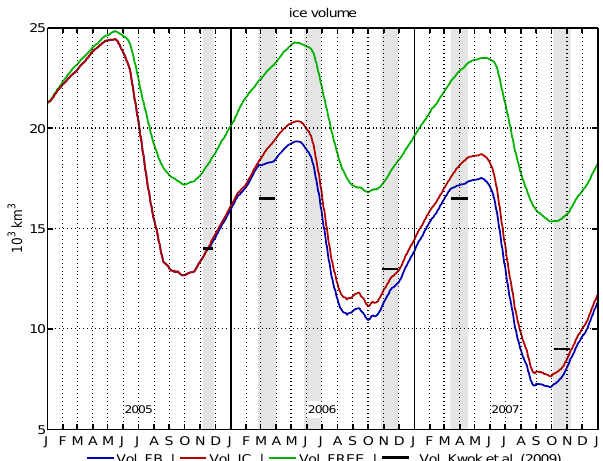
Fig. 5. Time series over 2005–2007 of the sea-ice volume in the Arctic Ocean for the FREE (green line), IC (red line) and FB (blue line) runs. Black lines are the mean sea-ice volumes provided by Kwok et al. (2009). The two sea-ice volume estimates (model and obs) are on the domain used in Kwok et al. (2009) (i.e. the Arctic Ocean). Gray areas indicate the periods when ice freeboard data are